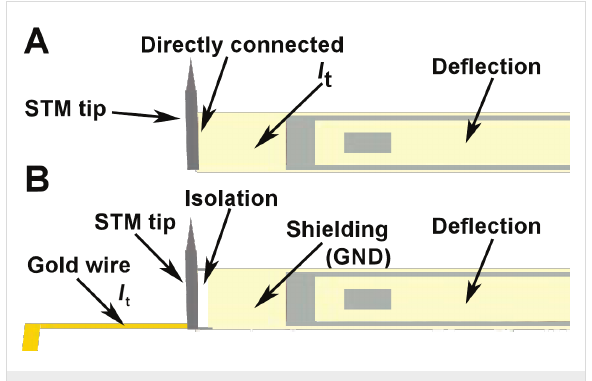
Figure 6: (A) Original connections in which one of the electrodes of the tuning fork was connected to the deflection amplifier and the second electrode was used for detection of the tunneling current. (B) To reduce the capacitance between the channels and eliminate any possibility of self-excitation, the tip is connected by a separated gold wire to the IVC and the electrode originally used for the tunneling current is now grounded. The wire and the tip is electrically isolated from the rest of the